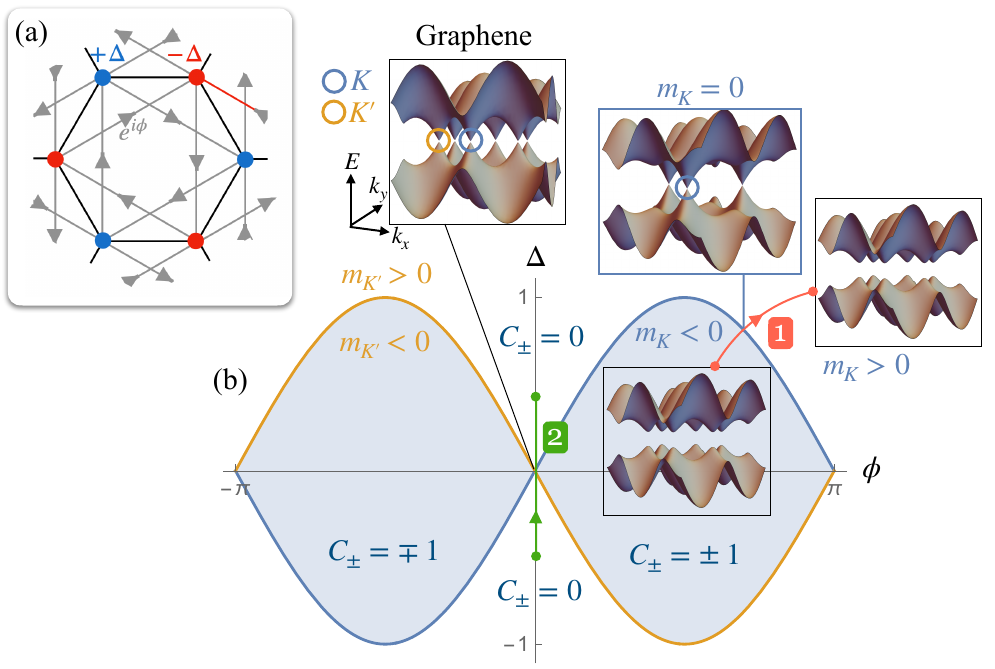
Figure 3: (a) Haldane model on the honeycomb lattice. (b) Phase diagram of the Haldane model. The topologically distinct insulating phases are characterized by the bulk Chern number C ± of each Bloch band over the Brillouin zone. They are separated by a gap closing point at either k = K or k = K (cid:48) . The gap amplitude is controlled by valley-dependent mass terms m closes at a single